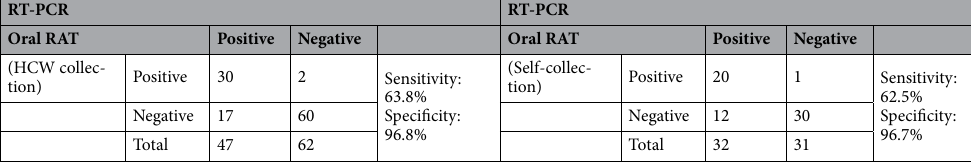
Table 2. Comparison of performance of Rapid Antigen Test with Oral Swab in symptomatic individuals: HCW versus self-collection. RAT Rapid antigen test, RT-PCR Reverse transcriptase-polymerase chain reaction, HCW Health care